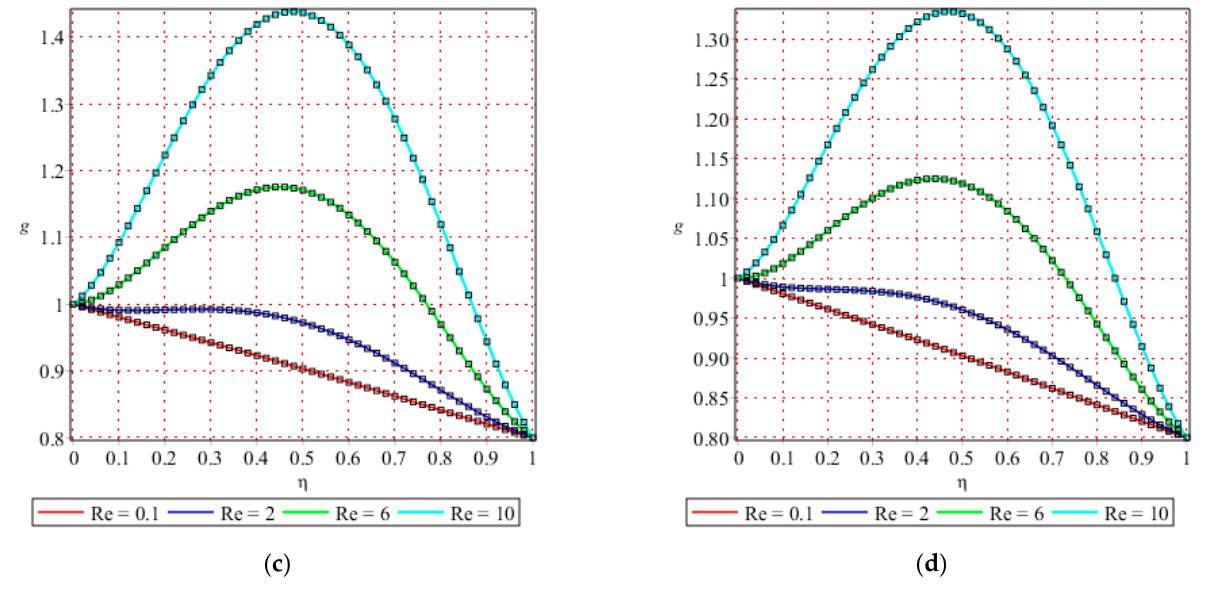
Figure 2. Influence of Re on velocities ( a , b ). Axial f ( η ) . ( c , d ). Tangential g ( η ) . ( a ) SWCNTs , ( b ) MWCNTs , ( c ) SWCNTs , ( d ) MWCNTs .